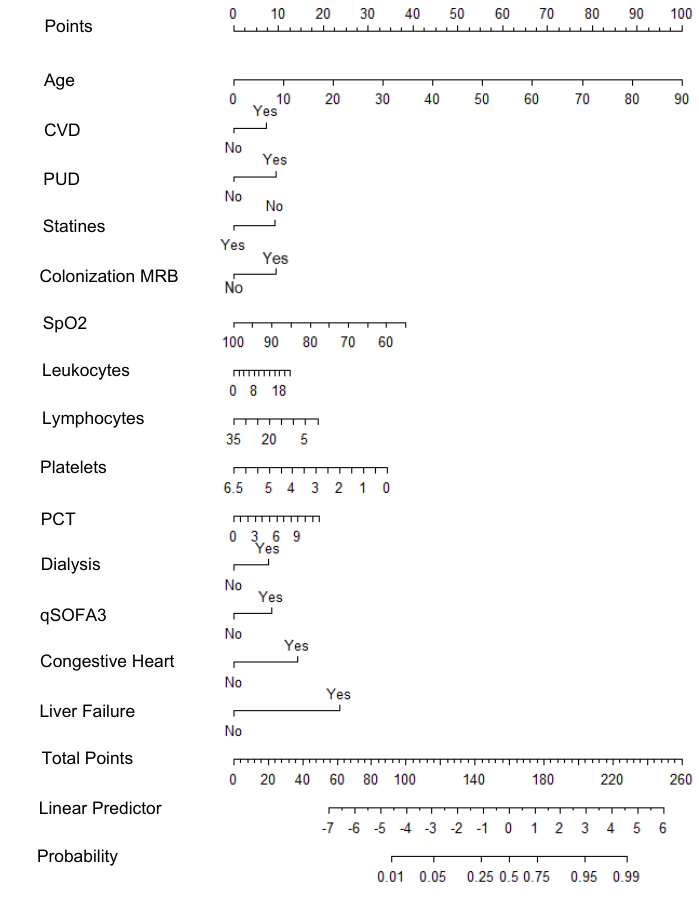
Figure 2. Nomogram graphically representing the logistic regression model for the probability of death of critically ill COVID-19 patients. The length of the scale next to each factor represents the relative importance of the corresponding variable. For a graphical estimation of the probability, first points corresponding to each factor can be found by a vertical line to the top scale. Adding all points results in the total points for this patient. Drawing a vertical line from the total points to the probability scale (scale at bottom) estimates the probability for a fatal